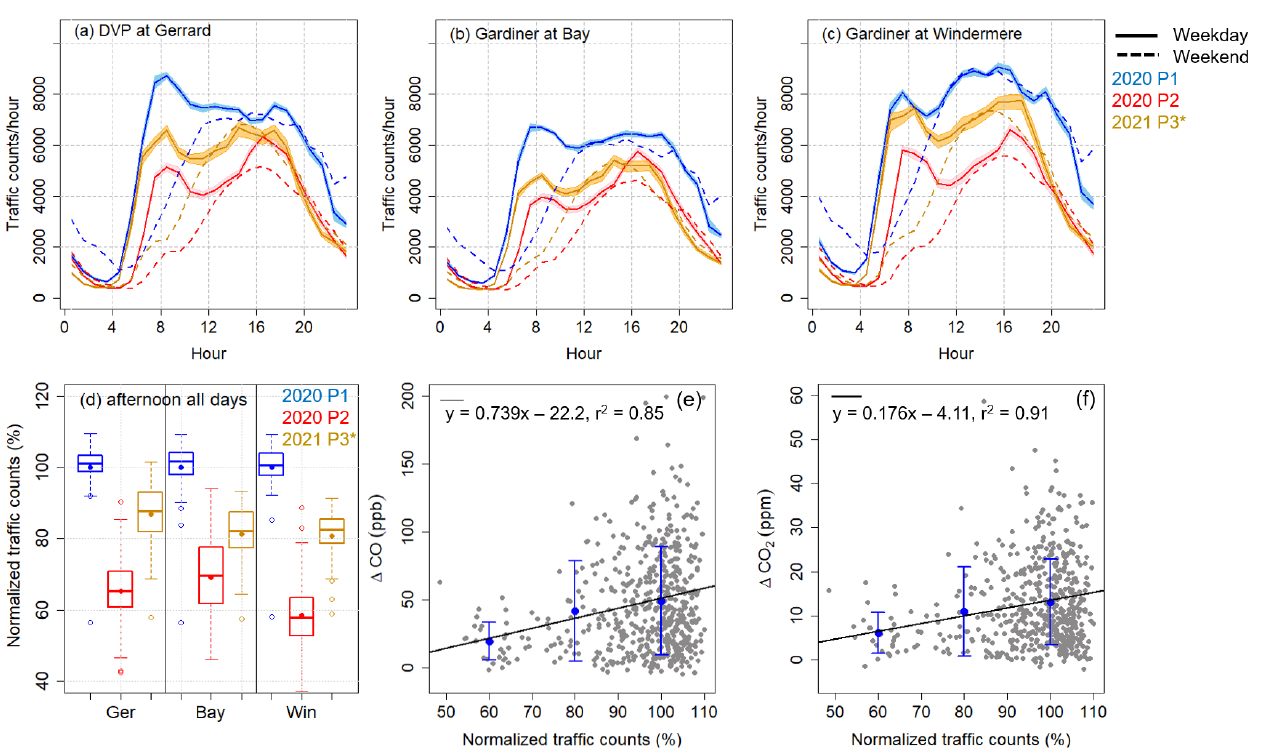
Figure 8. Diurnal variations of traffic counts at three intersections in downtown Toronto in 2020 and 2021: ( a ) DVP at Gerrard Street, ( b ) Gardiner at Bay Street, and ( c ) Gardiner at Windermere Avenue. Solid lines show the hourly means and corresponding shading marks the 95% confidence interval of the mean on weekdays, and dashed lines show the hourly means on weekends. ( d ) Normalized daily afternoon traffic counts for 2020 Period 1 (blue), 2020 Period 2 (red), and 2021 Period 3 (brown) at the same sites (Gerrard Street “Ger”, Bay Street, and Windermere Avenue “Win”). The reference for data normalization is the mean traffic for 2020 Period 1. The description of the box and whisker plot is the same as for Figure 1b. Scatter plots of daily afternoon ( e ) ∆ CO and ( f ) ∆ CO 2 vs. average normalized daily afternoon traffic counts at the three sites over the entire study period from November 2017 to March 2021. Blue points show average ∆ CO or ∆ CO 2 along the normalized traffic counts in three bins (50–70%, 70–90%, and 90–110%); the error bars represent 1 σ ; and the solid line shows the linear regression of the blue